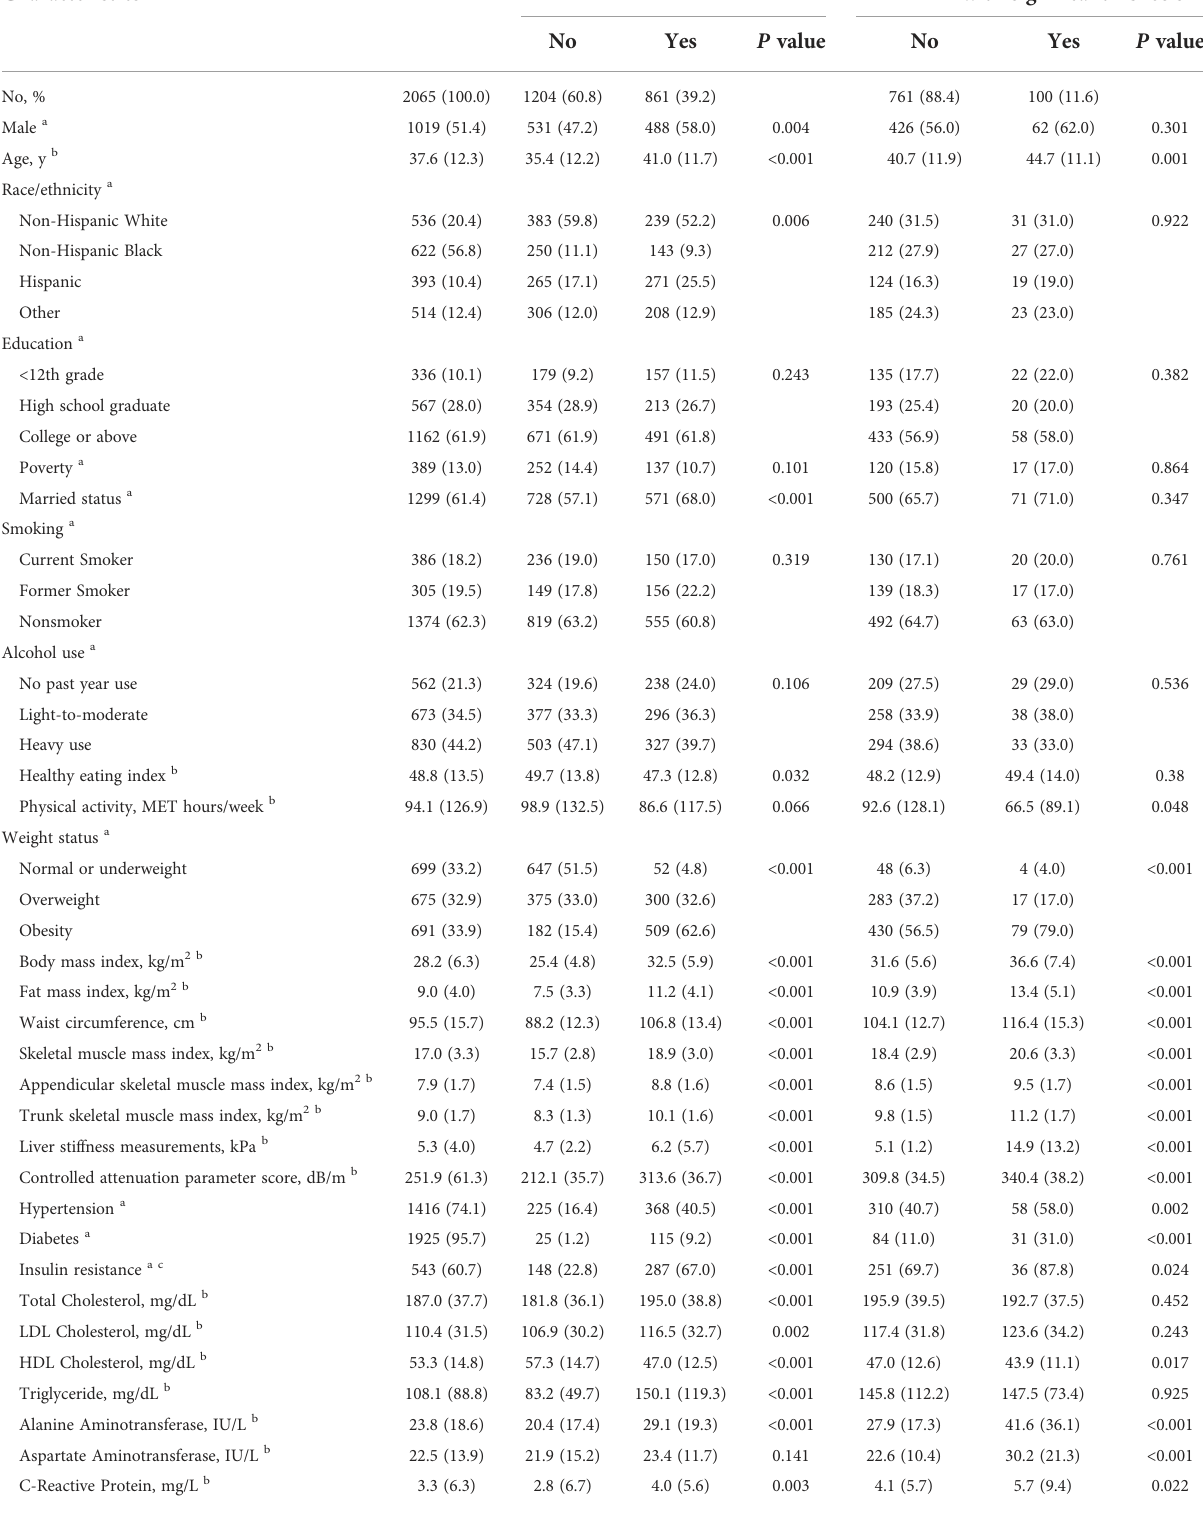
TABLE 1 Characteristics of study